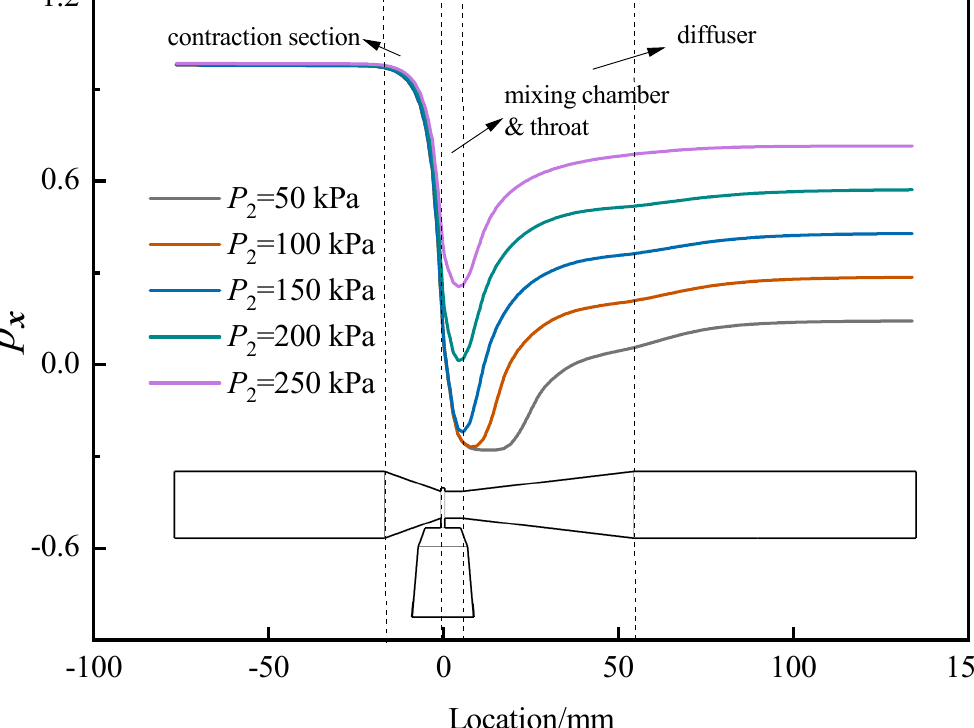
Figure 9. Local pressure ratios at different flow ratios.